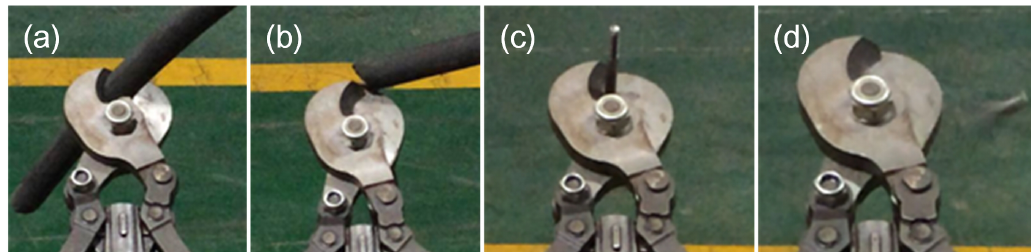
Figure 19. The cutting performance of the wrist joint assembly unit; ( a , b ) show scissors cutting cable; ( c , d ) shows cutting steel roll bar.